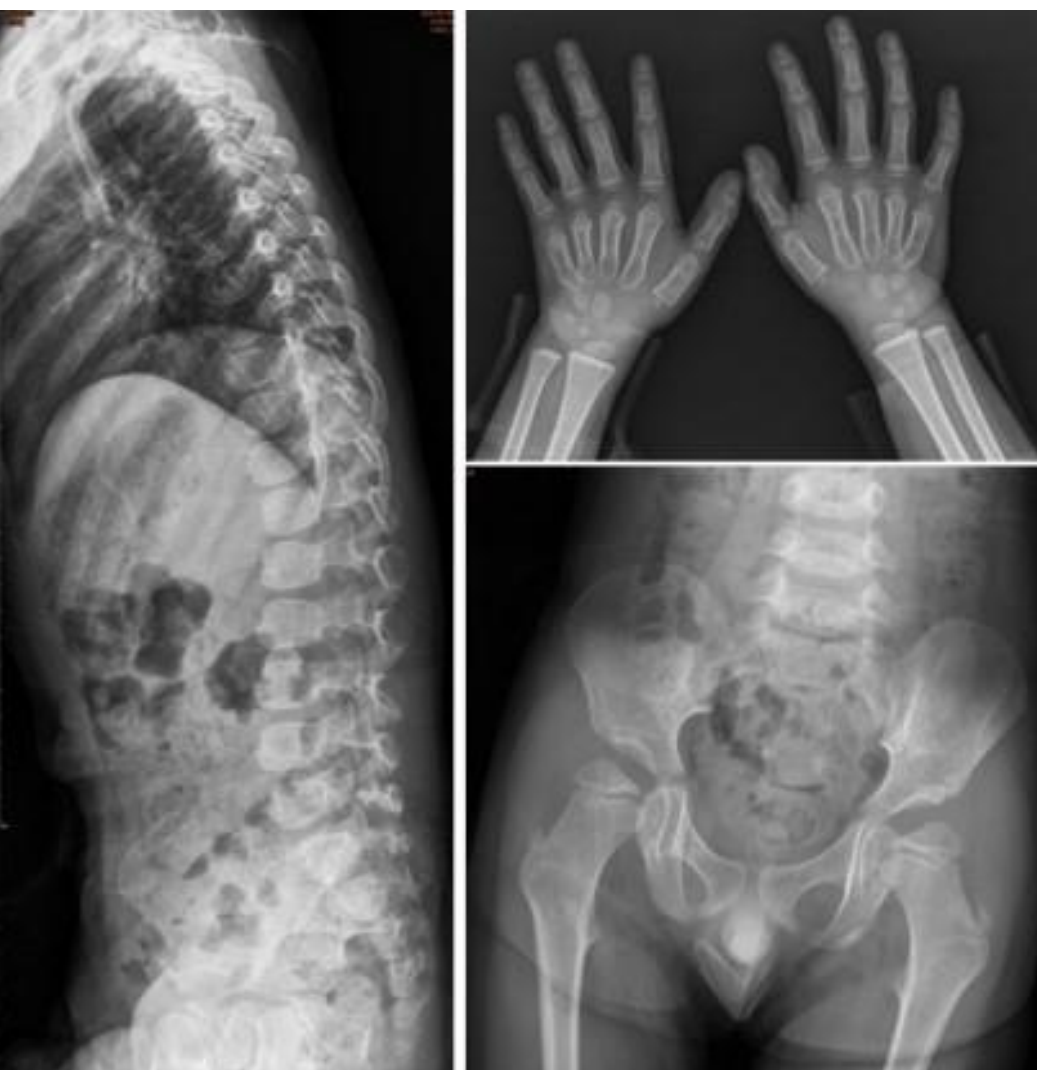
Figure 6. The bone X-rays at 3.2 years of age of patient No. I-5 who had the variation allele c.1400C > T [p.P467L]. He received ERT at 0.5 years of age. At 3.2 years of age, rounded and anterior beaking of lumbar spine vertebral bodies, mild proximal tapering of metacarpal bones with bullet-shaped phalanges, round iliac wings, and inferior tapering of the ilea with not-well-developed acetabulum were